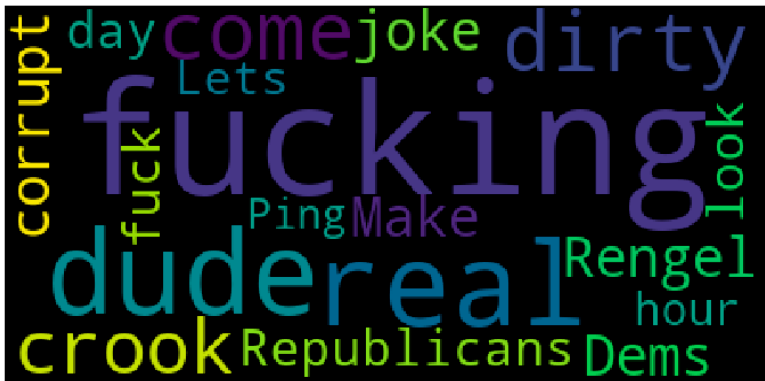
Figure 12. Word Cloud of Aggressive Class.